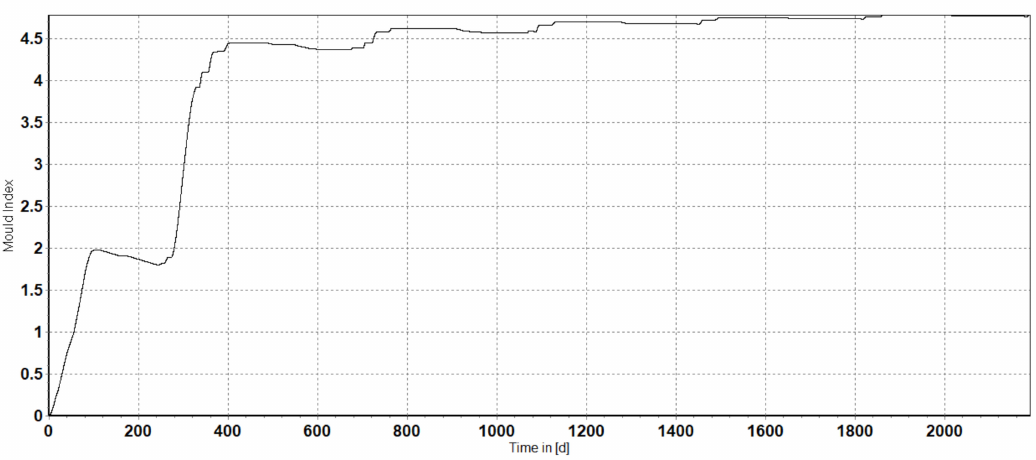
Figure 11. Mold growth index value between the insulation and the original wall. Reproduced with permission from